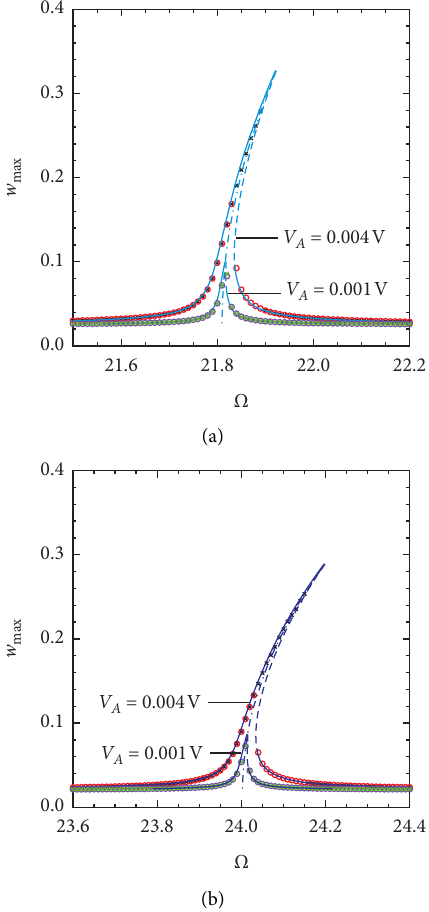
Figure 13: Amplitude-frequency curve: V � 10 4 (b) κ T